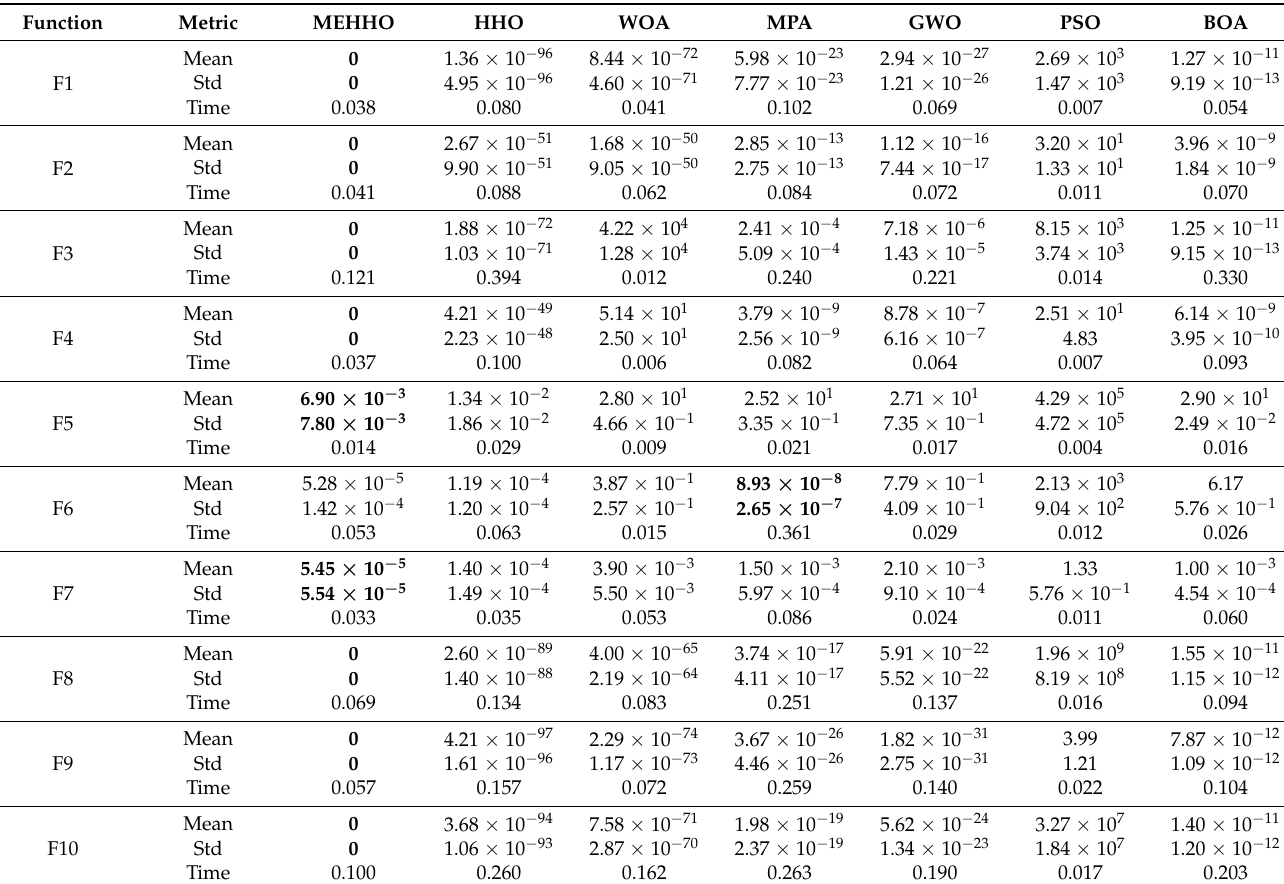
Table 4. Comparison of unimodal functions test results.